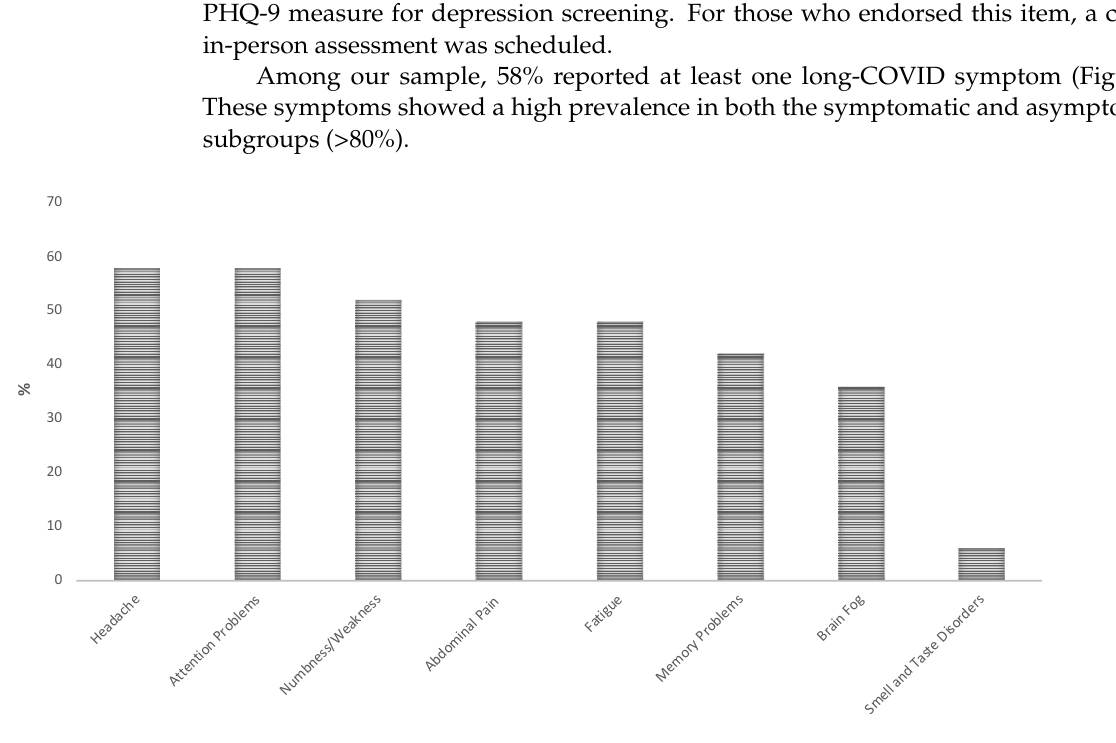
Figure 1. Reported long-COVID Symptoms.